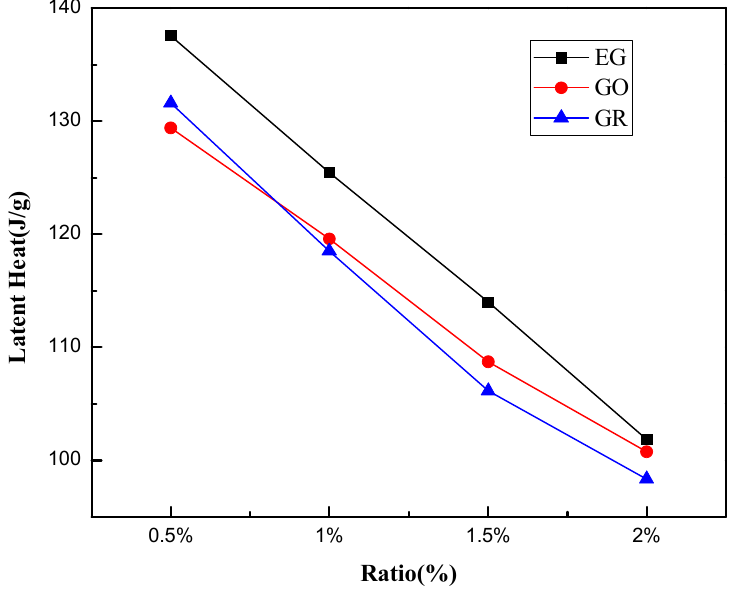
Figure 10. The latent heat of CPCM.